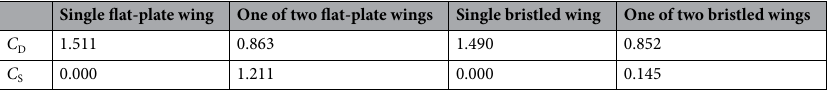
Table 1. Aerodynamic force coefficients of wings.